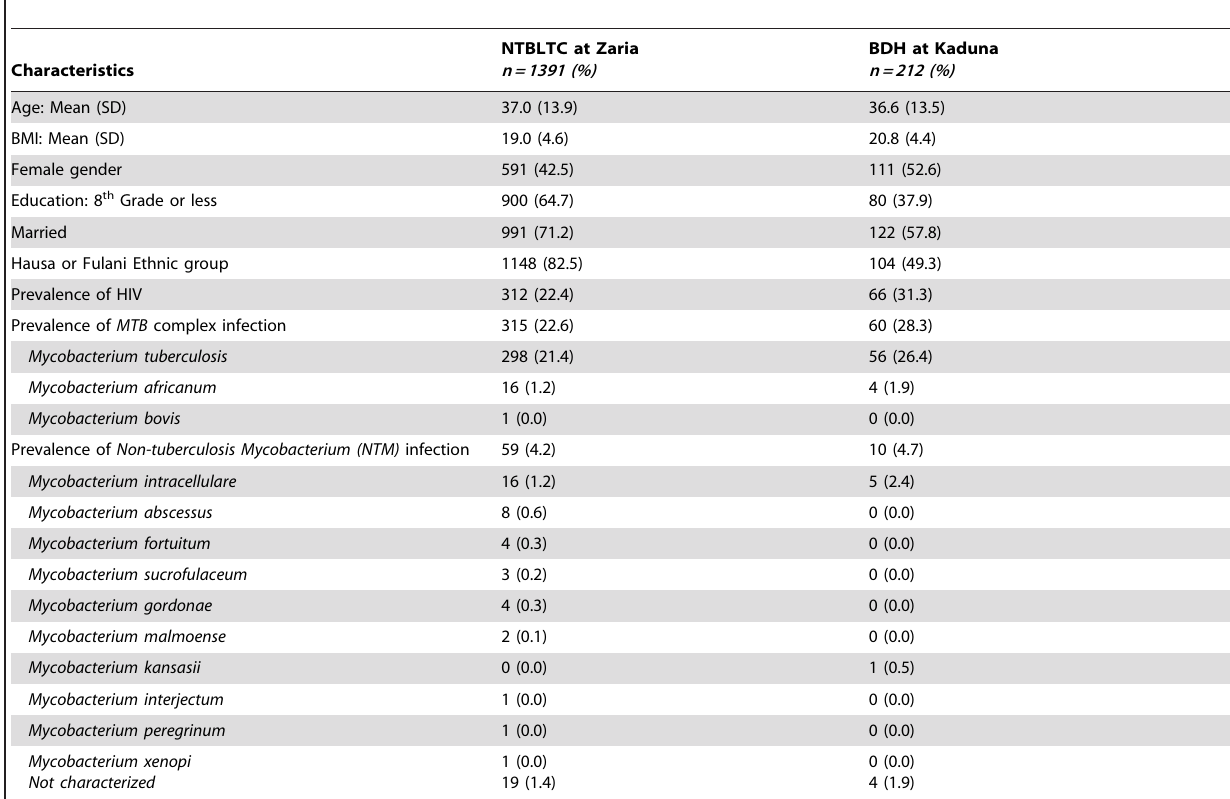
Table 1. Measured demographics and laboratory characteristics of participants stratified by site.